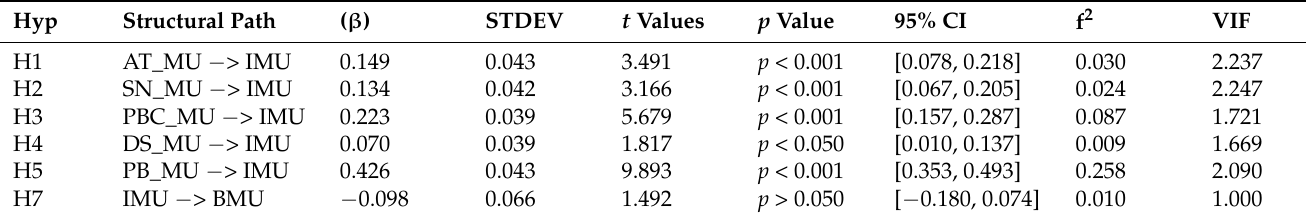
Table 6. Significant testing results of the structural model path coefficients.